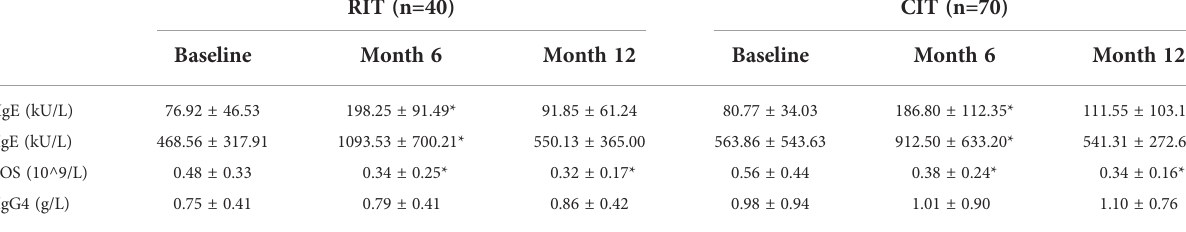
TABLE 5 Hematological parameters for patients in the RIT and CIT